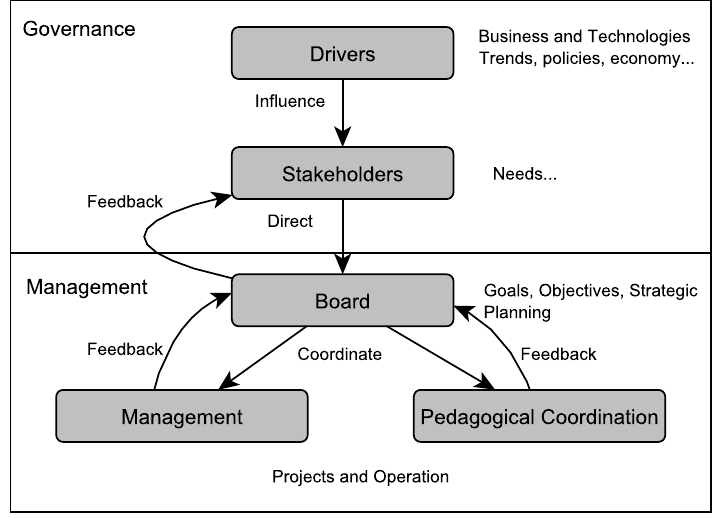
Figure 1. Macro-model of governance and educational